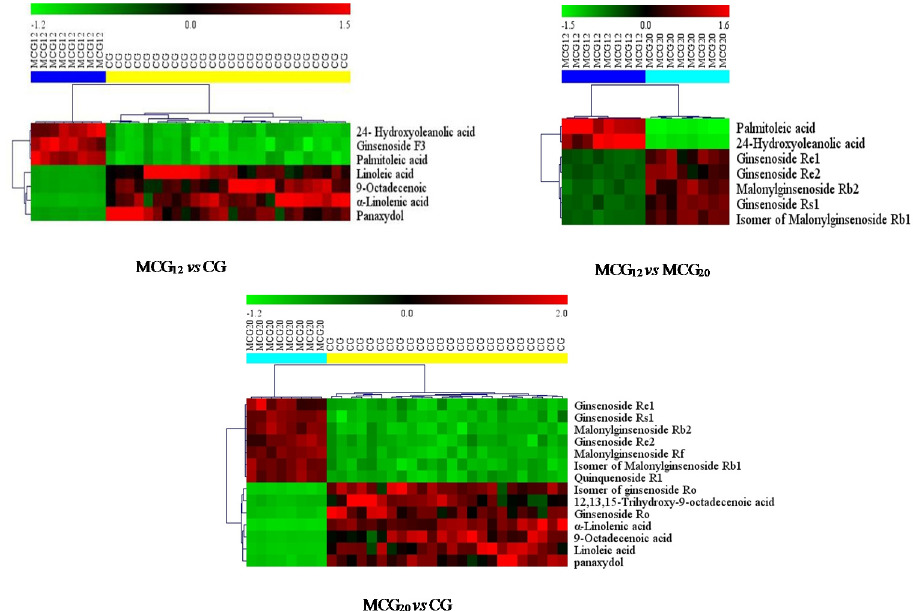
Figure 7. The heatmaps visualizing the intensities of potential biomarkers.